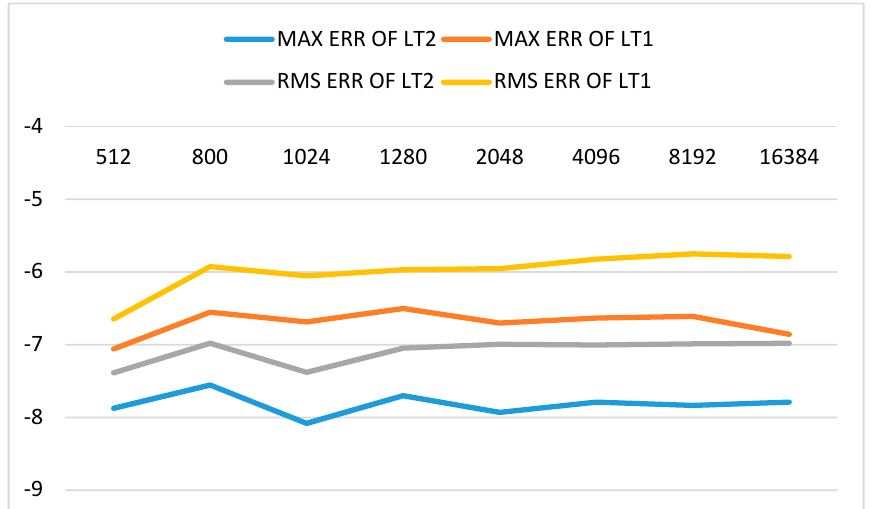
Figure 2. Errors of LT in log10 form with EPS = 1.0E-05 and CMAX = 64 (LT1 is the butterfly algorithm and LT2 is the proposed method. Abbreviations “MAX ERR” and “RMS ERR” denote the maximum error and root-mean-square error, respectively. EPS is desired precision in interpolative decomposition, CMAX is the number of columns in each sub-matrix on level 0).